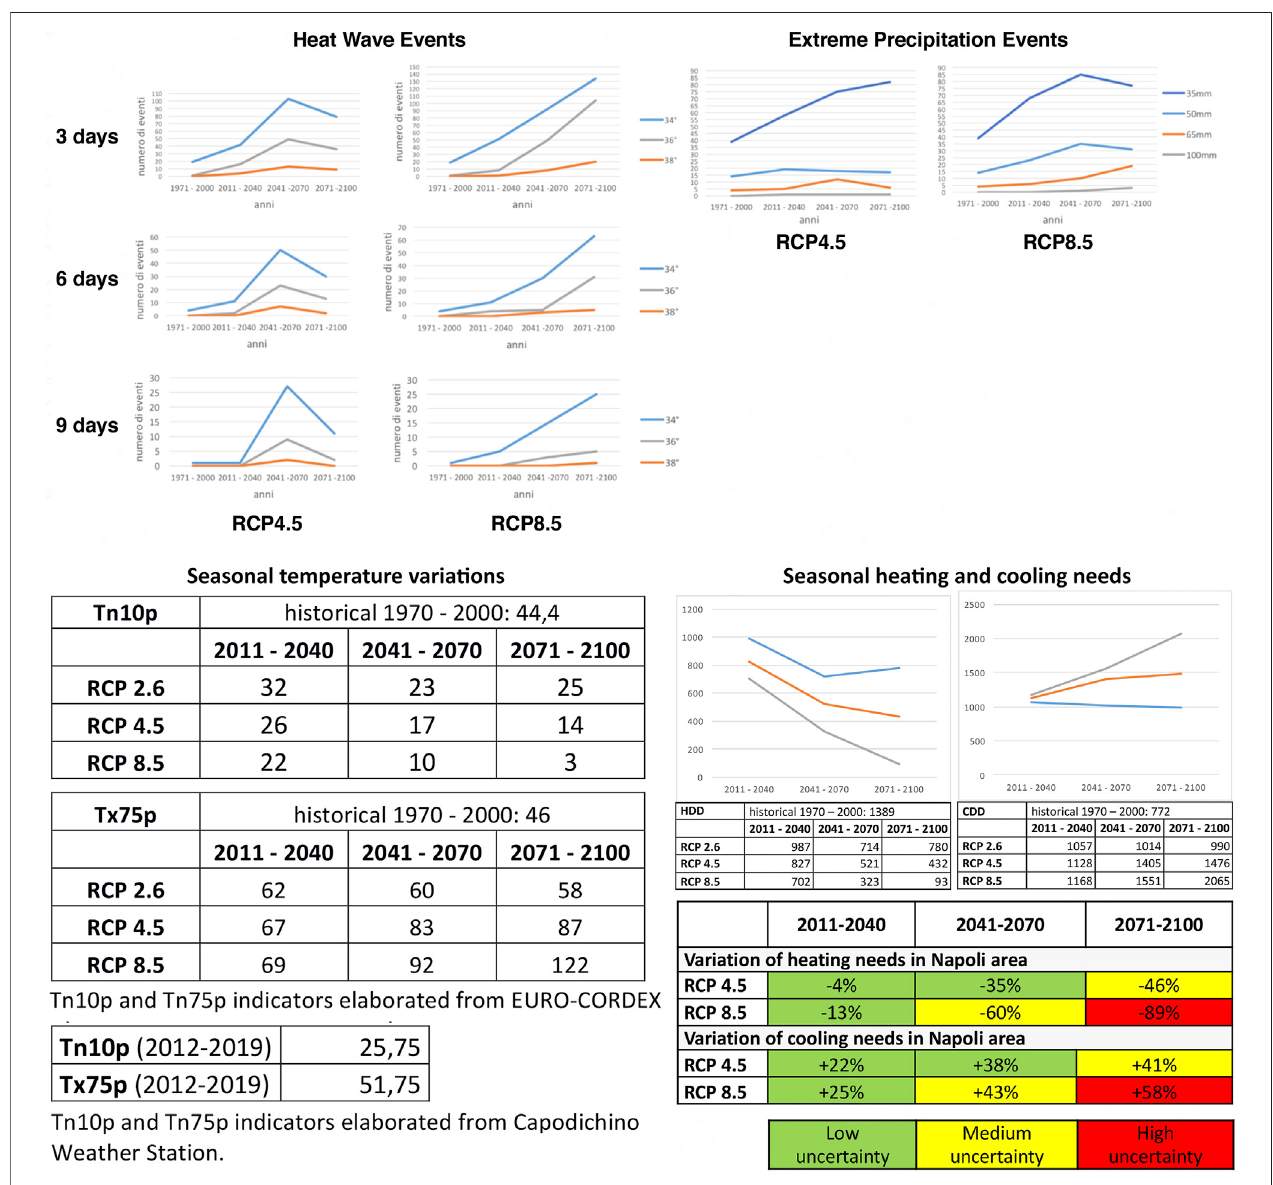
FIGURE7| Extremeeventsoftemperatureandprecipitation (top) ,seasonaltemperaturevariation (bottom-left) ,andheating/coolingneeds (top-right) inNaples.